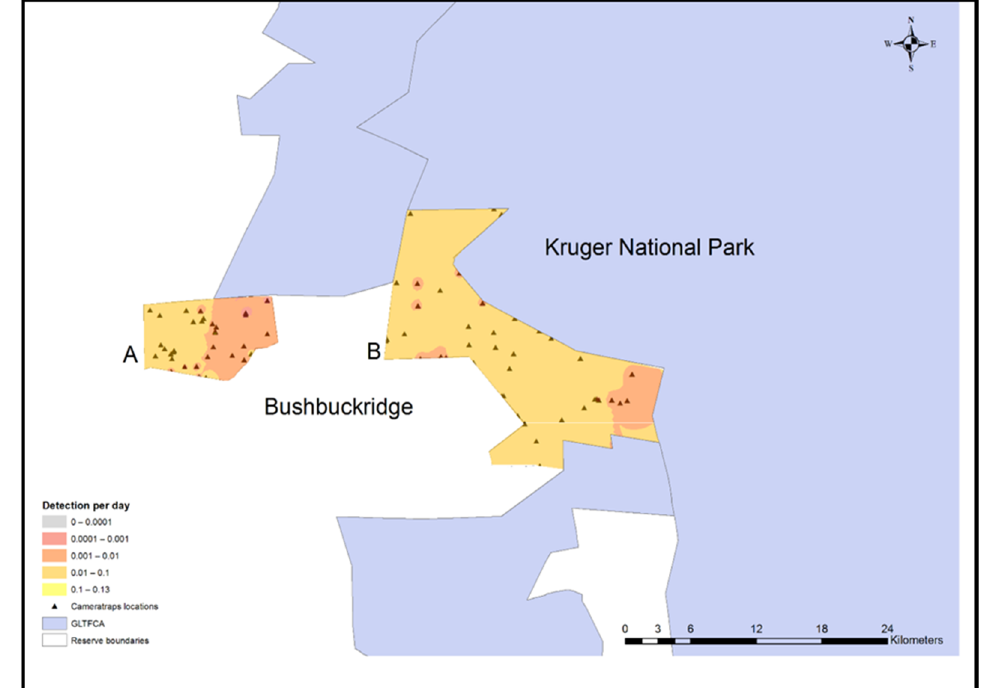
Figure 3. Any feline carnivore (lion, leopard, cheetah, and serval) daily detection model for Andover ( A ) and Manyeleti ( B ) nature reserves adjacent to Bushbuckridge human settlements and Kruger National Park, Mpumalanga Province, South Africa, 2015–2017 3.